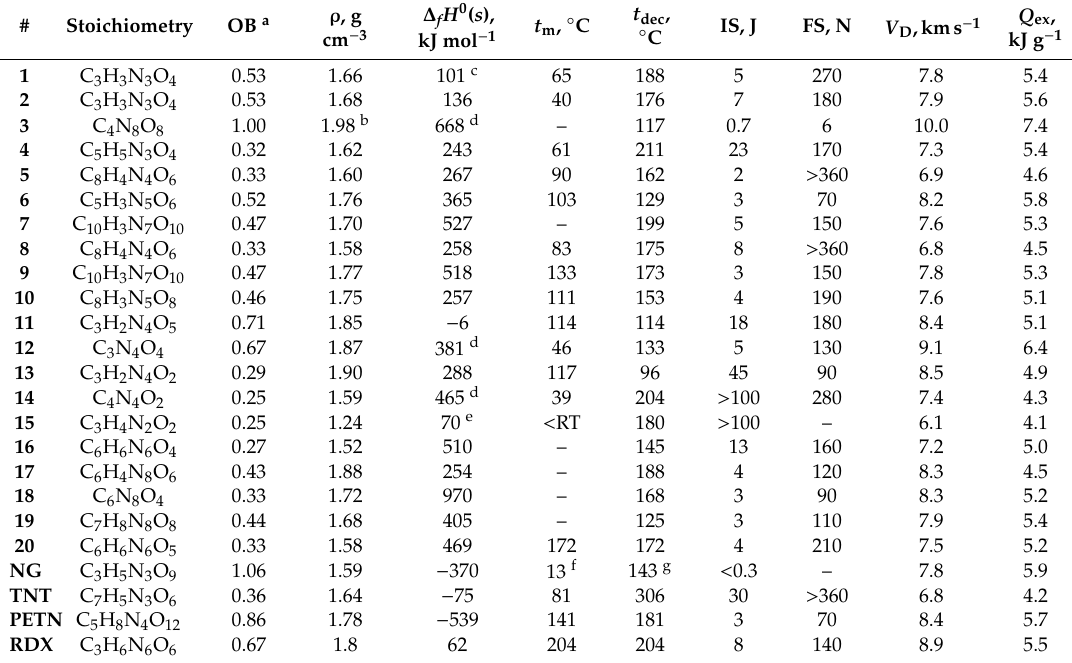
Table 2. The summary of the physical, safety, and energetic properties of the compounds 1 – 20 along with the reference energetic materials: trinitrotoluene (TNT), pentaerythritol tetranitrate (PETN), and hexogen (RDX). All data, except otherwise noted, are from the present